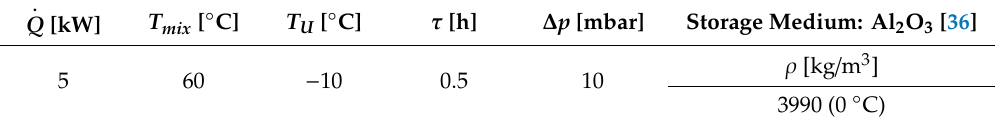
Table 3. Storage medium—specifications and selected material.